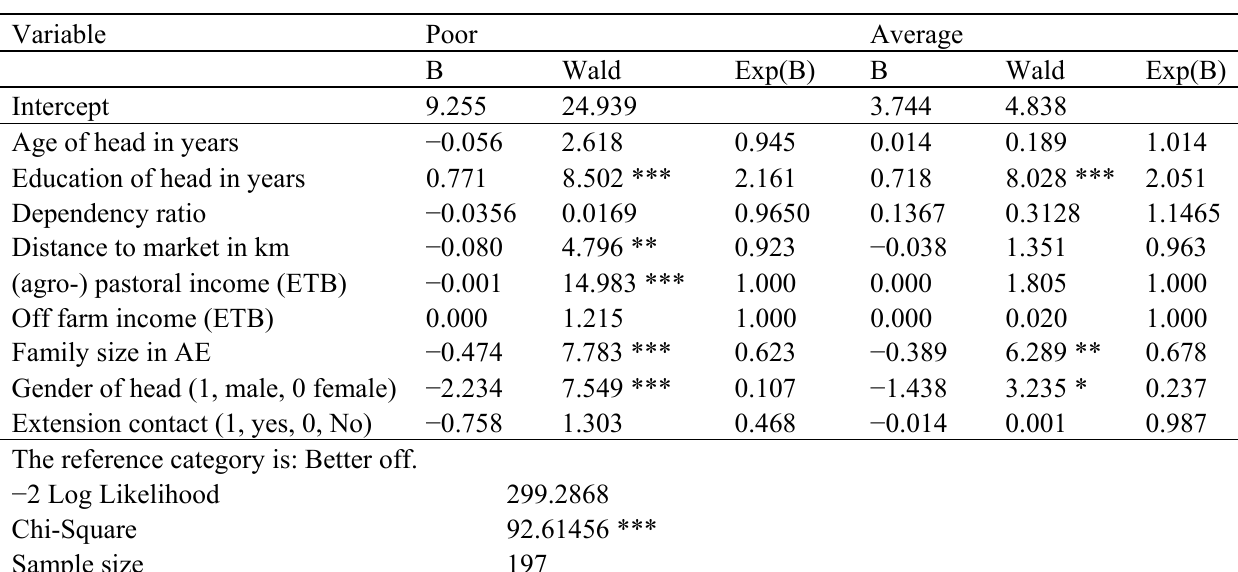
Table 6. Multinomial regression of determinants of well-being